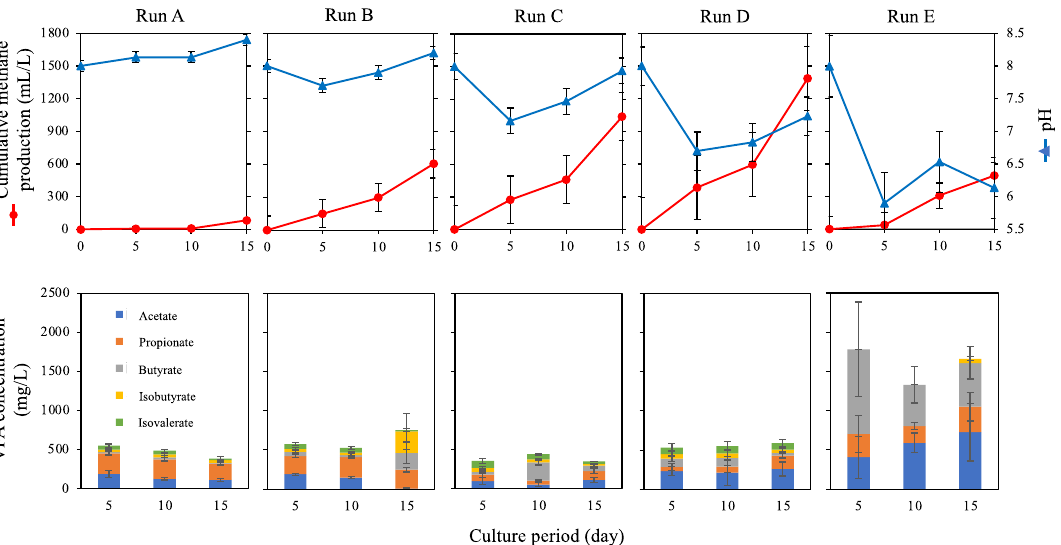
Figure 1. Cumulative methane production and pH changes (upper row), and concentration of VFA (lower row) in the batch cultures with simulant beverage waste mixture (SBWM). The amounts of SBWM added were 0, 0.5, 2, 5, and 10 mL for runs A, B, C, D, and E, respectively. Experiments were performed in triplicate, and error bars represent standard deviations.